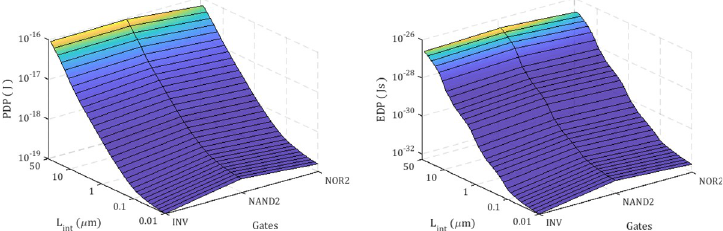
Fig 9. (a) PDP and (b) EDP of silicene-based digital logic circuits. INV, NAND2 and NOR2 represent inverter, 2-input NAND and 2-input NOR gates,